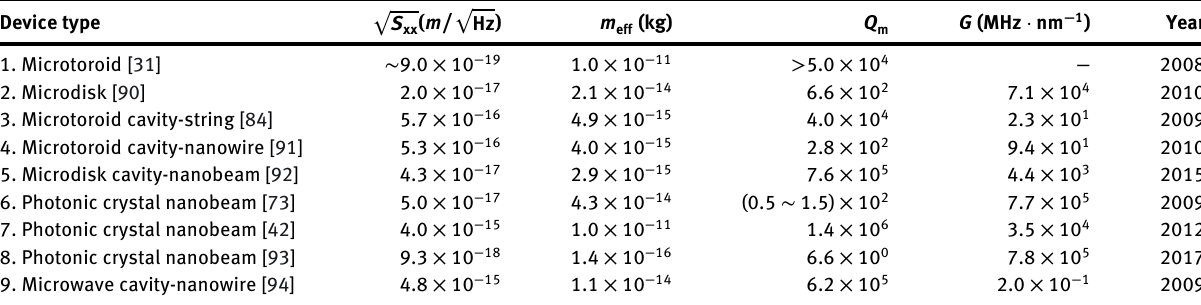
Table 1: Experimental parameters for a representative sampling of published cavity-based displcement sensors experiments. Device